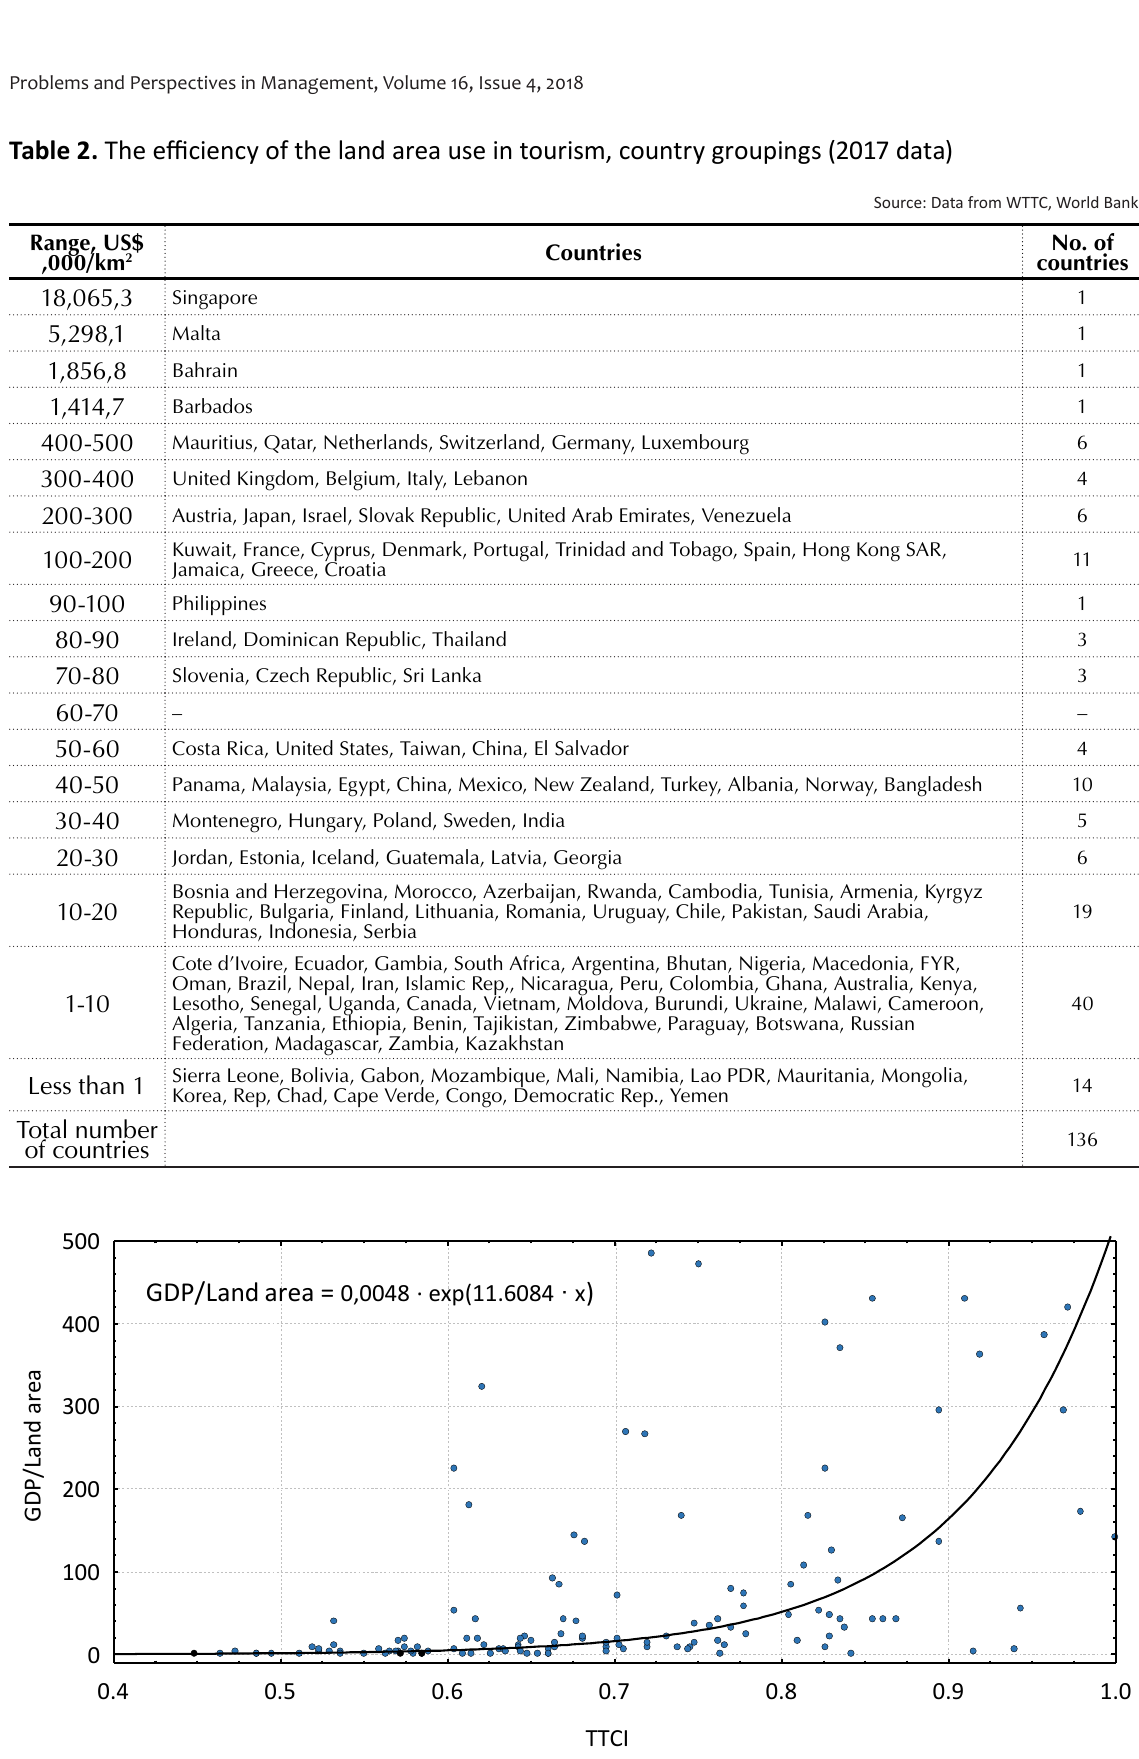
Table 2. The efficiency of the land area use in tourism, country groupings (2017 data)